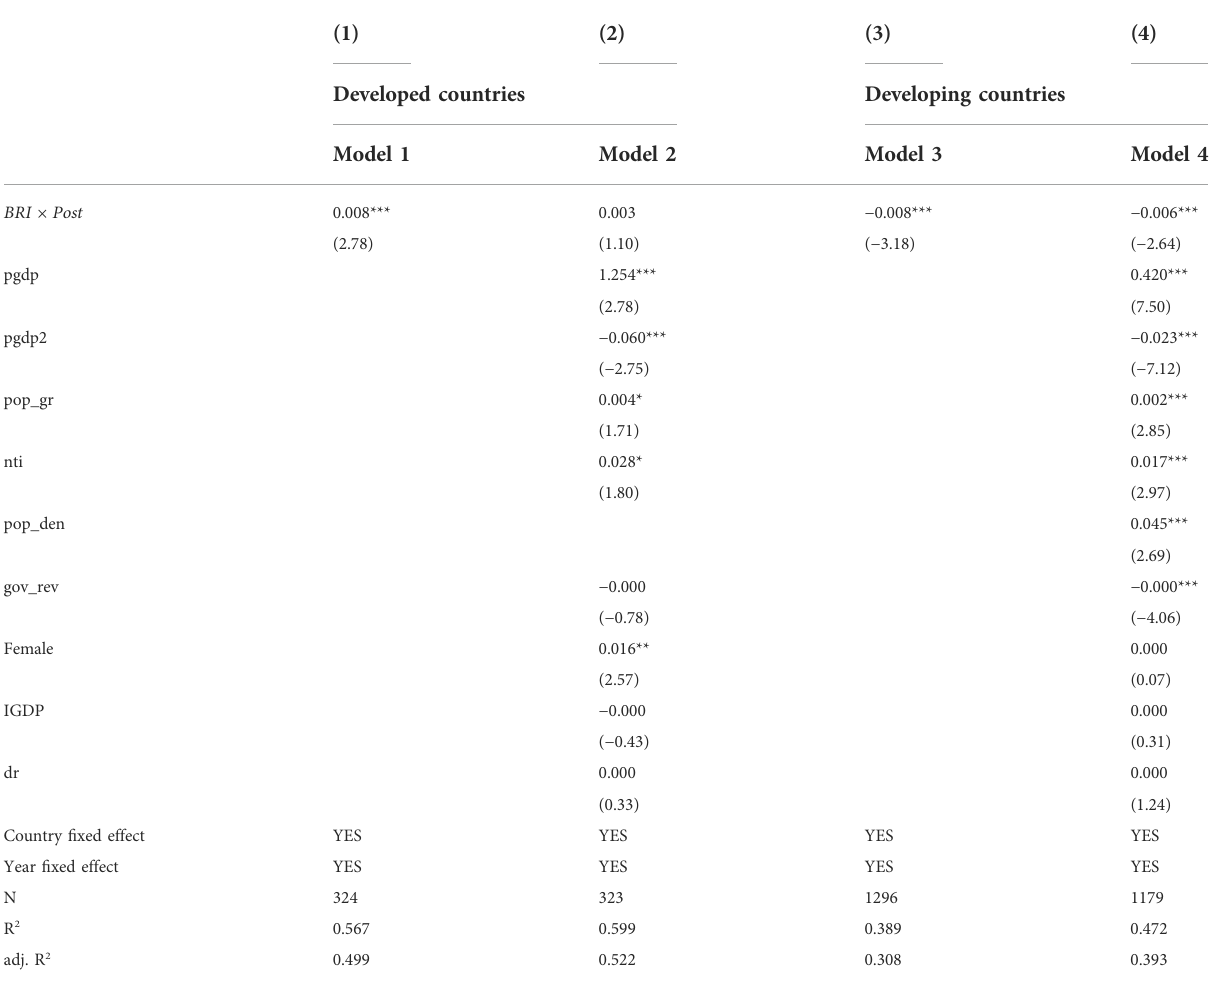
TABLE 12 Effects of the Belt and Road Initiative on environmental quality: Economic